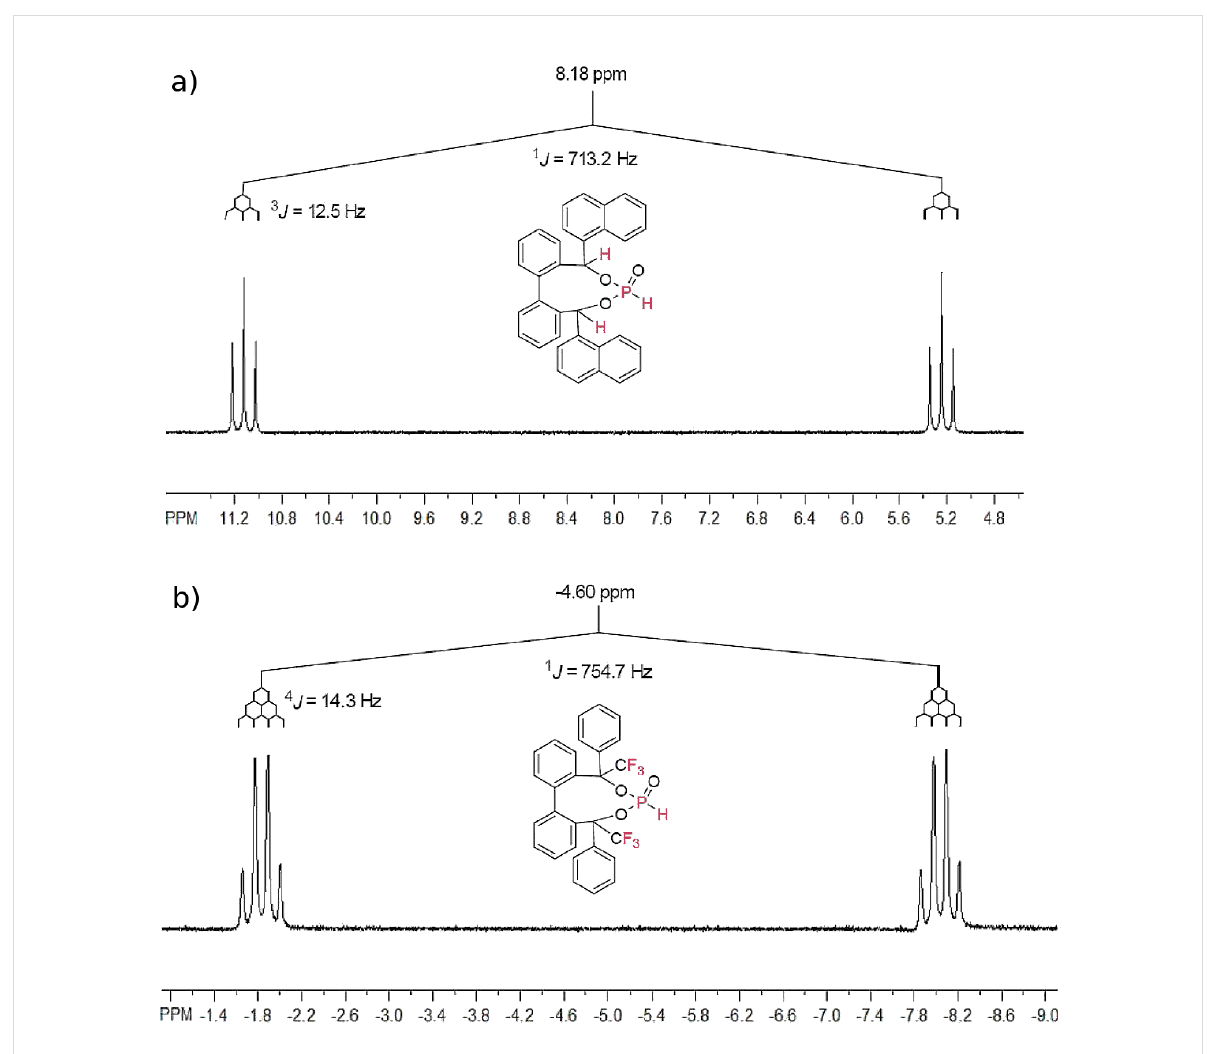
Figure 3: 31 P NMR of phosphonate 14 (a) and 15